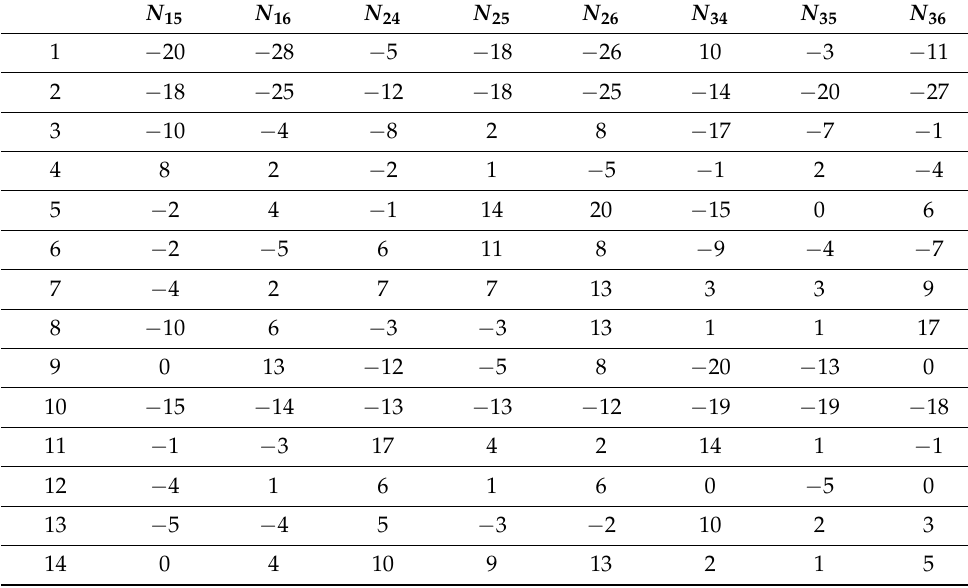
Table 4. DD integer ambiguities across the two cells using the broadcast integer ambiguities of the proposed framework.